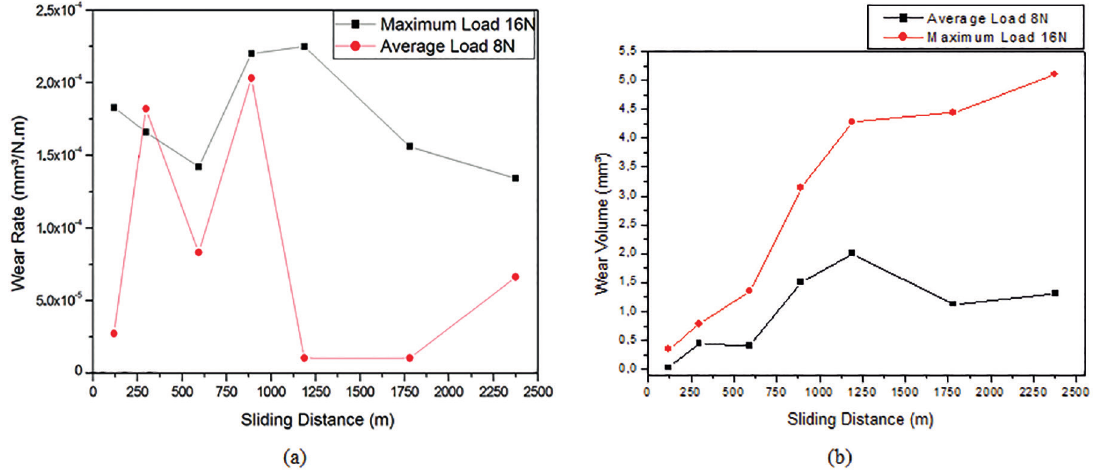
Figure 6: (A) Change in the wear rate with the sliding distance and (B) wear volume as a function of the covered distance for 16-N and 8-N